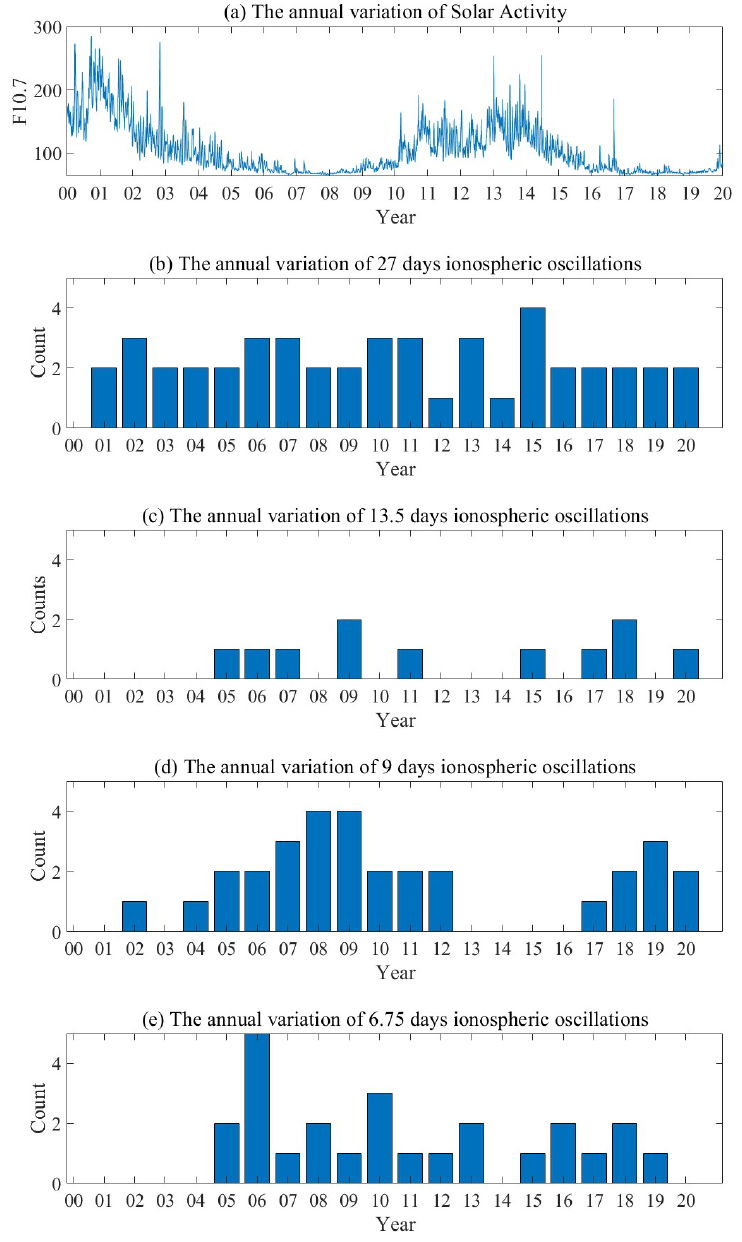
Figure 6. The annual variation in solar activity and ionospheric oscillations with periods centering at the four harmonic periods of solar rotation. The relationships between ionospheric oscillations and solar activity and geomag- netic activity were statistically determined. The relationships are divided into four types: 1) forced by both solar-geomagnetic activities; 2) forced by solar activity only; 3) forced by geomagnetic activity only; and 4) unforced by both solar and geomagnetic activities. As